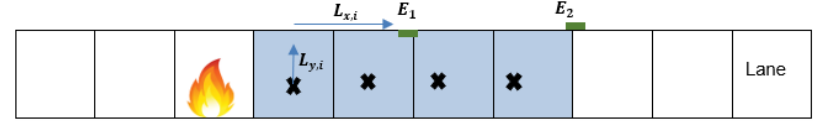
Figure 3. C (cid:2869),(cid:2869) escape path based on the initial position.